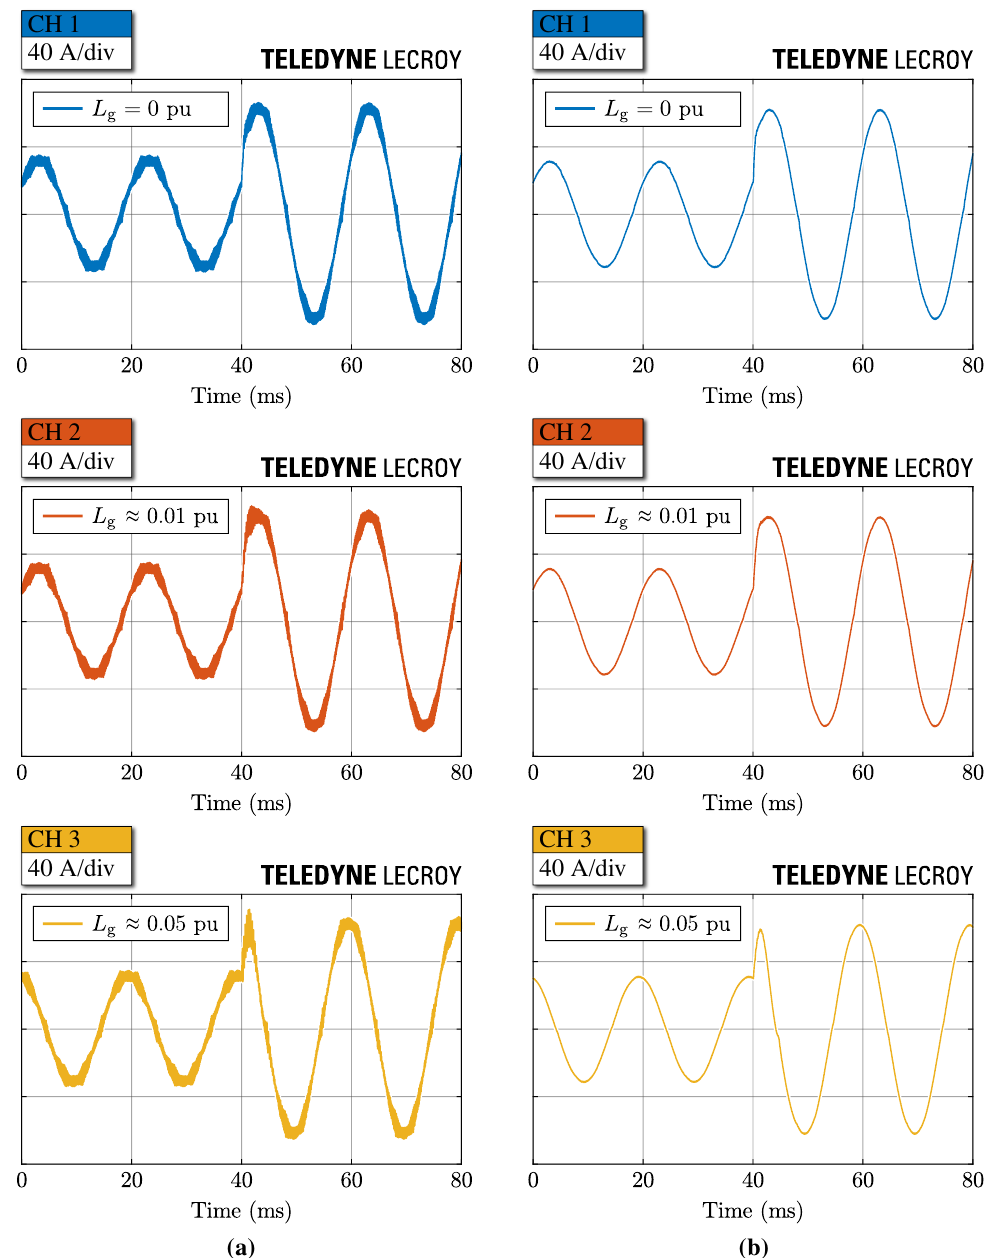
Figure 22. Experimental current control loop step response between 50% and 100% load for different values of grid inductance L g : ( a ) converter-side current i and ( b ) grid-side current i f